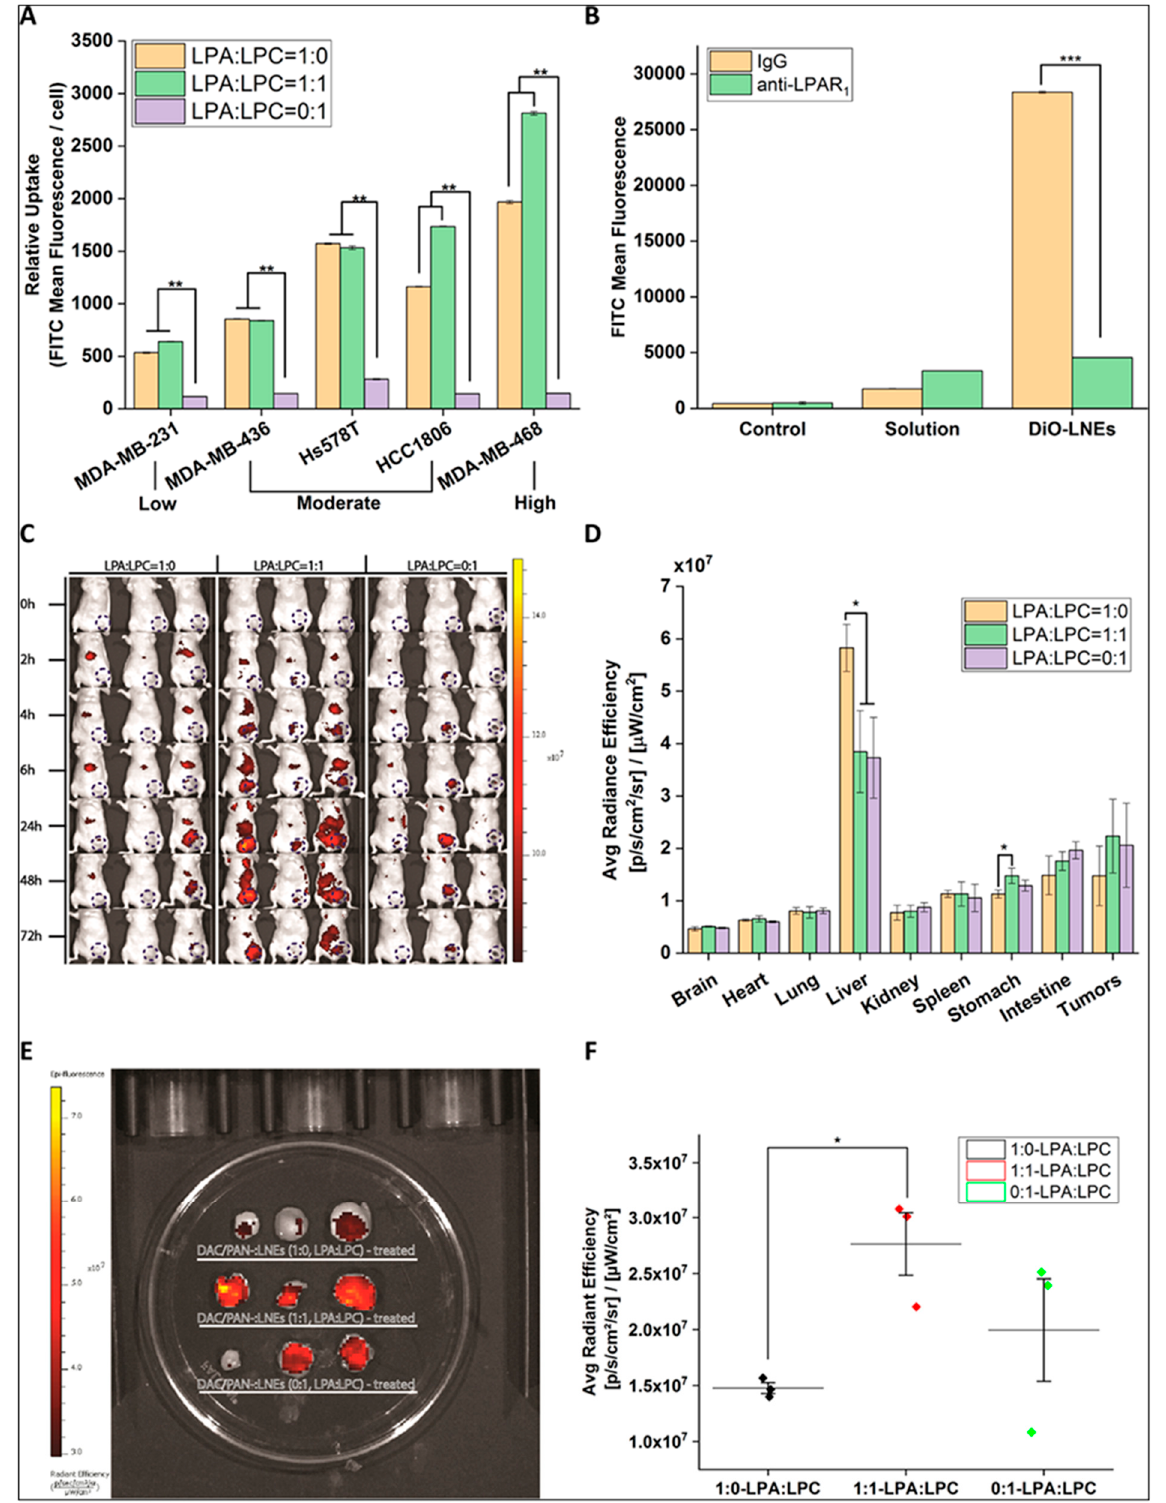
Figure 9. Cellular uptake and biodistribution of lipid nanoemulsion (LNE). ( A ) Different levels of LPAR1 by flow cytometry in TNBC cell lines after incubated for 2 h with Rho-LNEs. Similarly, ( B ) shows cellular uptake of LNEs via flow cytometry, which was pre-incubated with either IgG or anti- LPAR1 at 10 μ g/mL concentration for about 1 h followed by incubation with DiO-LNEs. ( C ) Whole body DiR-LNEs radiance for 72 h post IV injection. ( D ) Biodistribution of DiR-LNEs in various or- gans, which were later quantified ex vivo by IVIS for 72 h post IV injection. ( E , F ) Radiance from